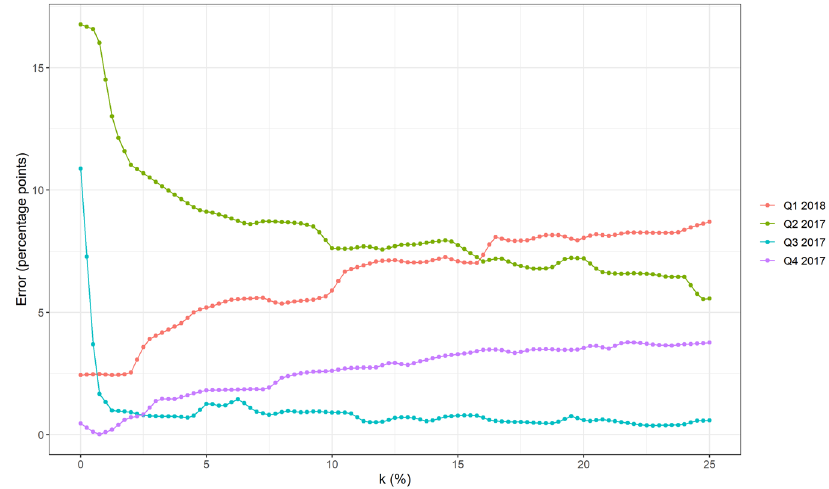
Fig. 3 Winsorization and predictive accuracy. The algorithm ’ s absolute prediction errors under different levels of